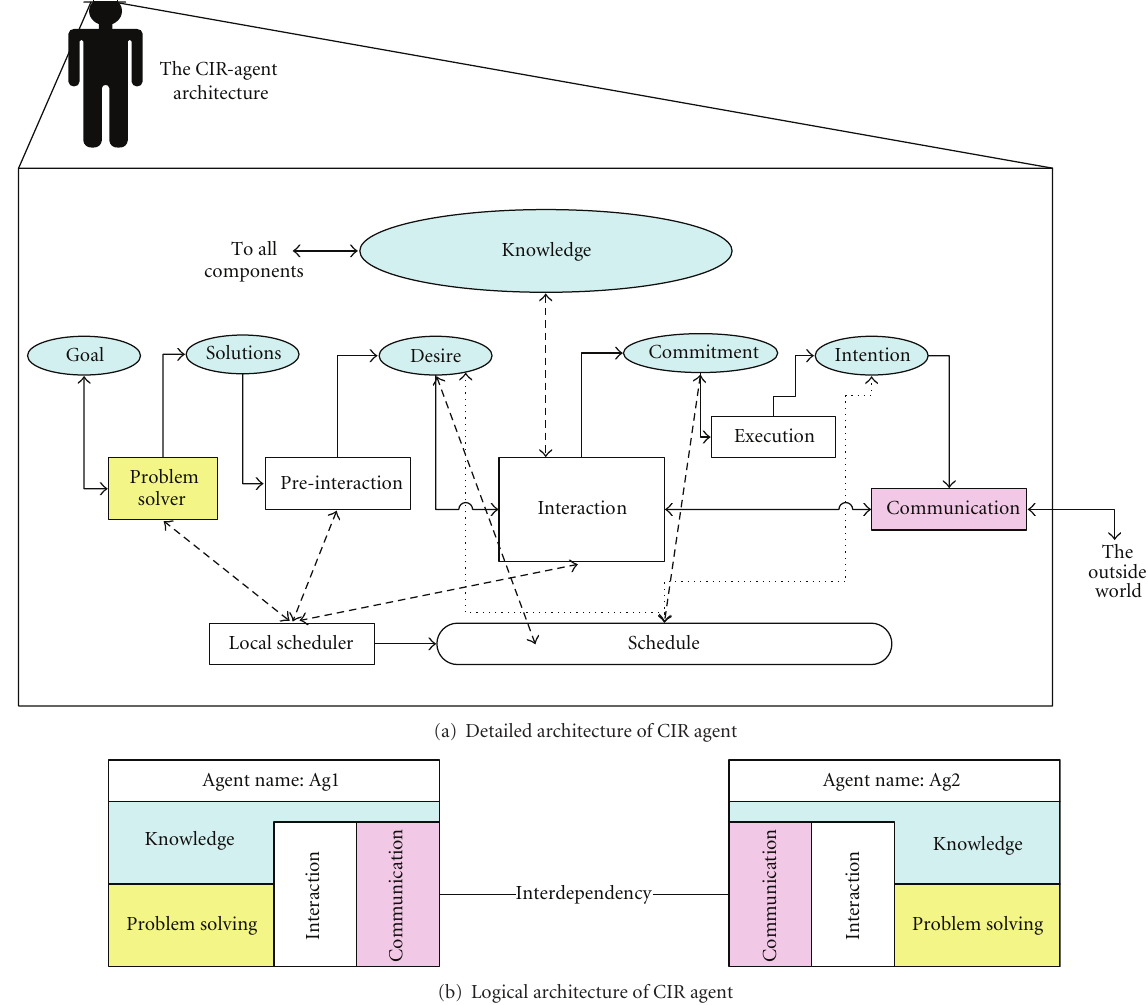
Figure 10: The CIR agent